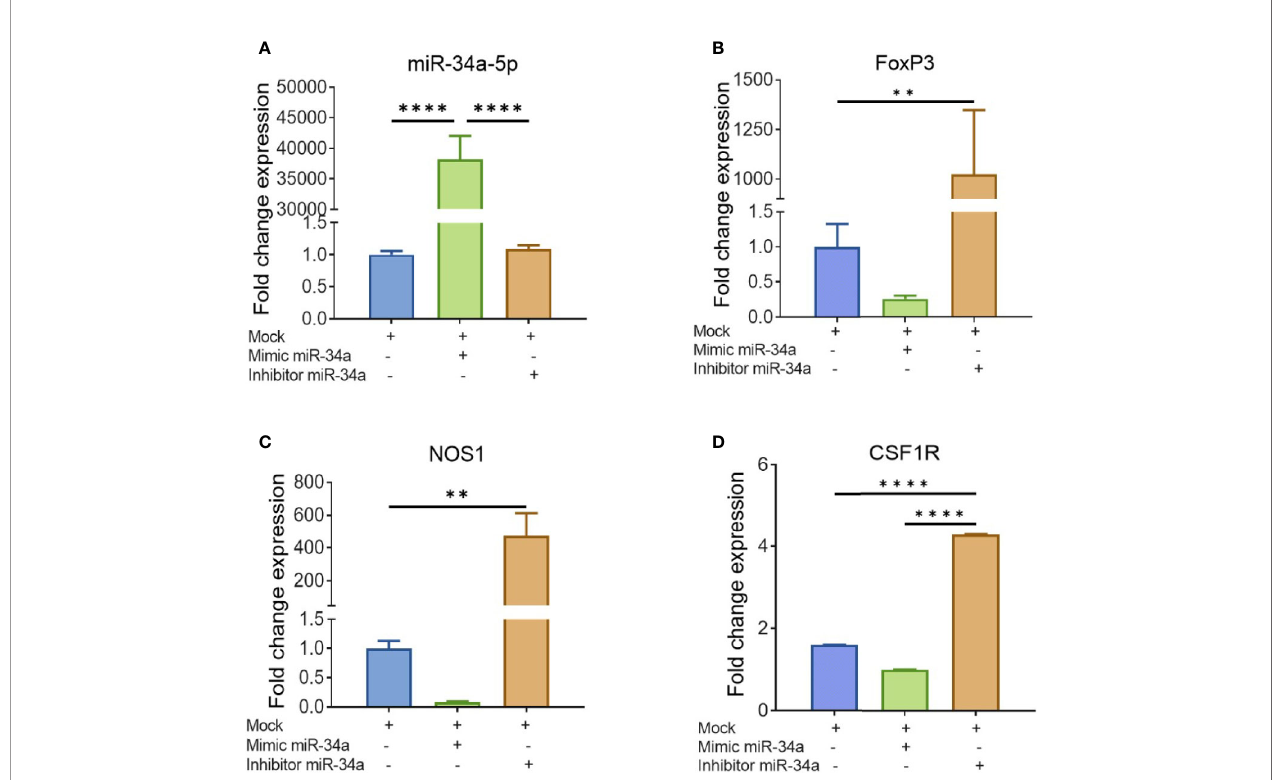
FIGURE 7 | Validation of genes targeted by miR-34a-5p: Splenocytes harvested from a group of four naïve C3H/HeJ mice were cultured and activated with SEB overnight followed by transfection with mock, mimic or inhibitor of miR-34a-5p. RT-PCR was used to detect the levels of targeted genes. (A) miR-34a-5p expression with mock, mimic or miR-34-5p inhibitor. (B – D) Expression of FoxP3 (B) , NOS1 (C) , and CSF1R (D) in the presence of mock, mimic or miR-34-5p inhibitor. Data presented as vertical bars represent Mean ± SEM of triplicates. Different gene expression in panels (A – D) was calculated as normalized to mock control group gene expression ( DD C T ). Statistical signi fi cances are depicted as **p < 0.01, ****p < 0.0001 between the compared